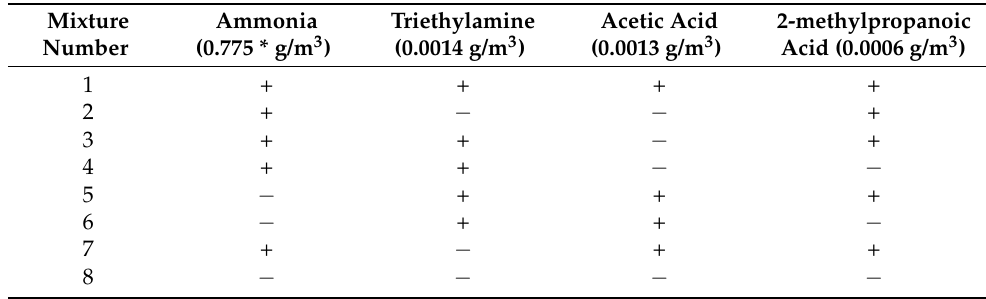
Table 3. Composition of model gas mixtures of volatile organic